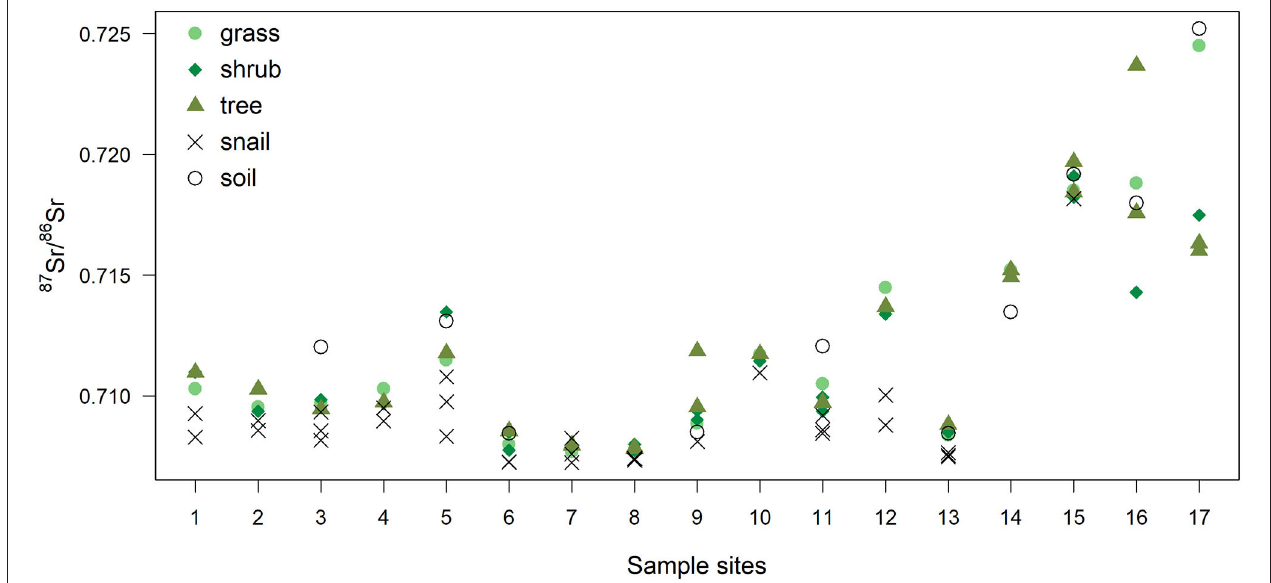
FIGURE 2 | 87 Sr/ 86 Sr values of plants (grass, shrub, tree), snails and soil for each site. Sites for biological and soil samples were different. Soil 87 Sr/ 86 Sr values presented are from the closest site sampled within 1km from each plant sampling site, and include data from Willmes et al. (2014), and unpublished data from Moffat (2013) (see Supplementary Table 1 ).